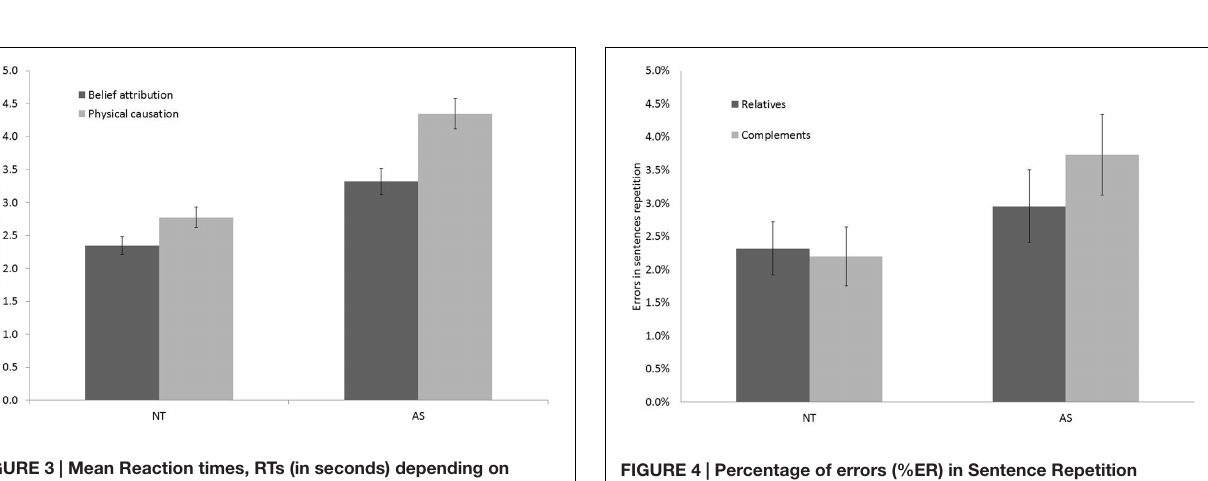
FIGURE 4 | Percentage of errors (%ER) in Sentence Repetition according to Group (NT, and AS) and Syntax (Relatives and